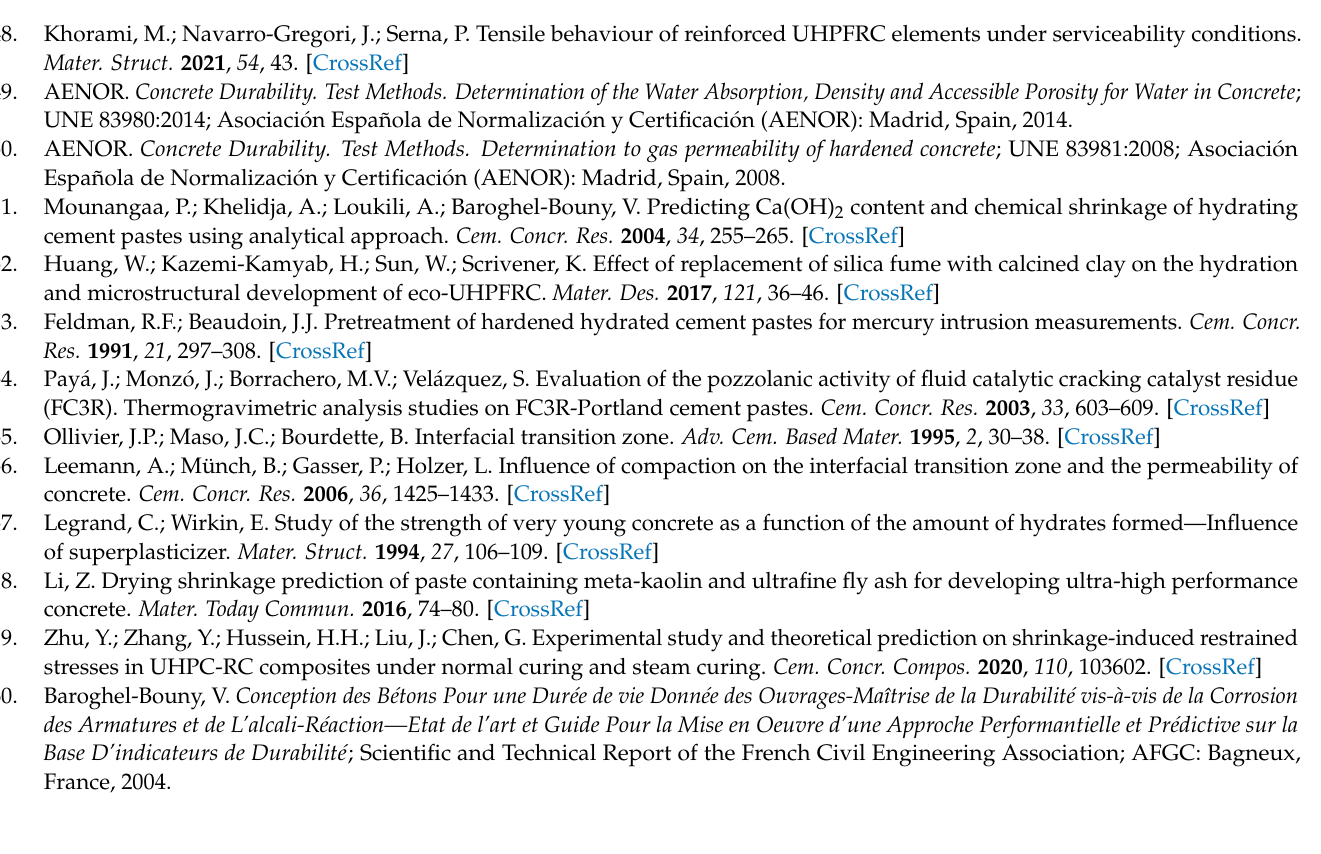
Base D’indicateurs de Durabilit é ; Scientific and Technical Report of the French Civil Engineering Association; AFGC: Bagneux, France,